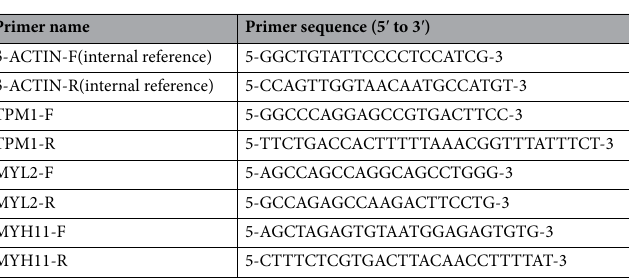
Table 2. Sequences of the primers used in reverse transcription-quantitative